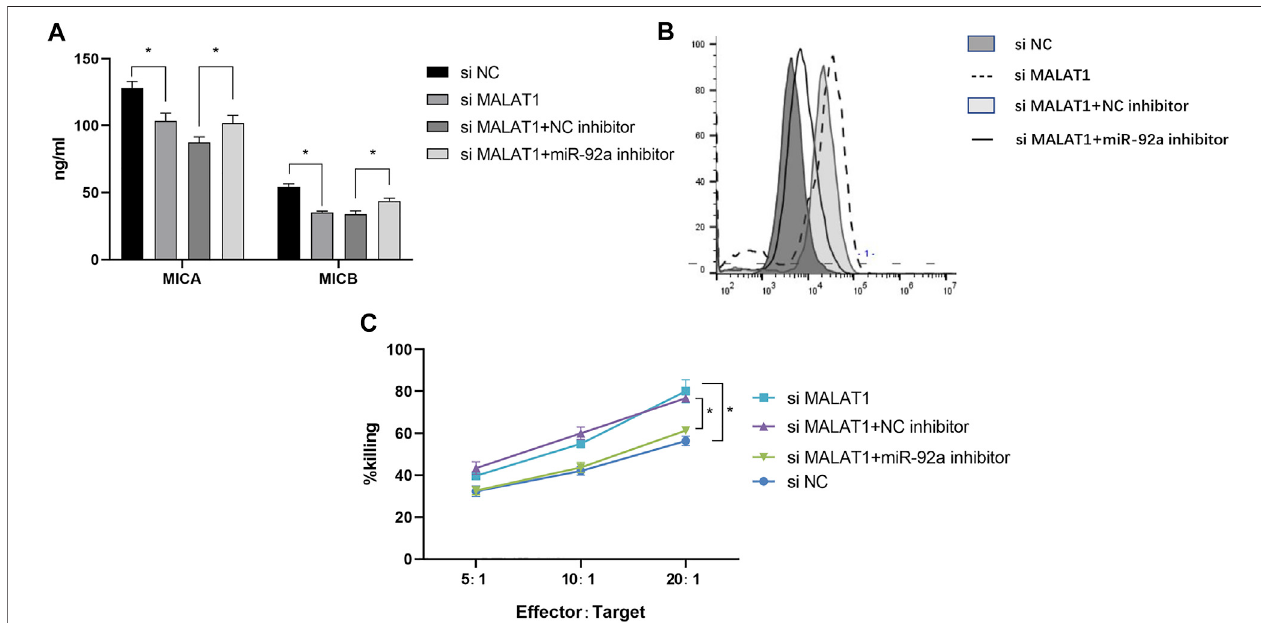
FIGURE6| MALAT1 silencing inhibits MICA/B release and inhibits theimmuneescape ofsenescent cells. (A) Followingco-transfection ofan miR-92a-3p inhibitor and si-MALAT1 into IMR-32 cells, cells were treated with MLN8237 to induce cell senescence, and ELISA was performed to detect MICA/B levels in the culture supernatant. (B) Flow cytometry analysis of MICA/B expression on the cell surface. (C) Killing ef fi ciency was detected by the calcein-AM method in co-cultures at effector:target cell ratios of 5:1, 10:1, and 20:1. Cells co-transfected with different vectors were used as target cells, normal human NK cells were used as effector cells. Data represent the mean ± standard error of the mean of three independent experiments. * p <